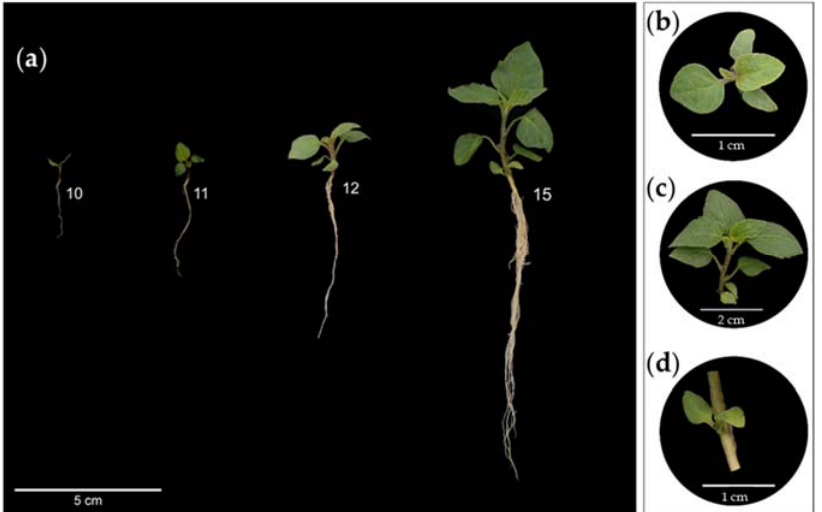
Figure 6. Principal stage 1 (leaf development) ( a ), pubescent ( b ) and serrated ( c ) leaves, and cotyledons ( d ) of slender nightshade plants ( Solanum nigrescens ): 10: cotyledons completely unfolded; 11: first true leaf on main shoot fully unfolded; 12: second leaf on main shoot fully unfolded; 15: fifth leaf on main shoot fully unfolded. Photos by Sara Monzerrat Ramírez-Olvera.